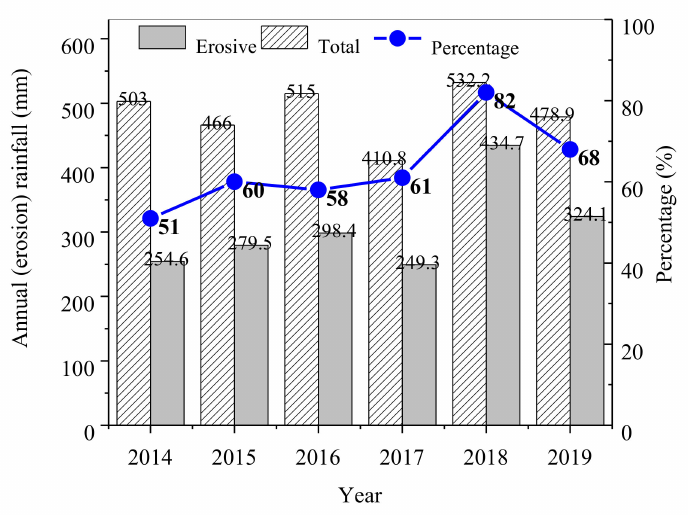
Figure 2. Total annual and erosive rainfall amounts and the percentages of erosive rainfall to annual total in